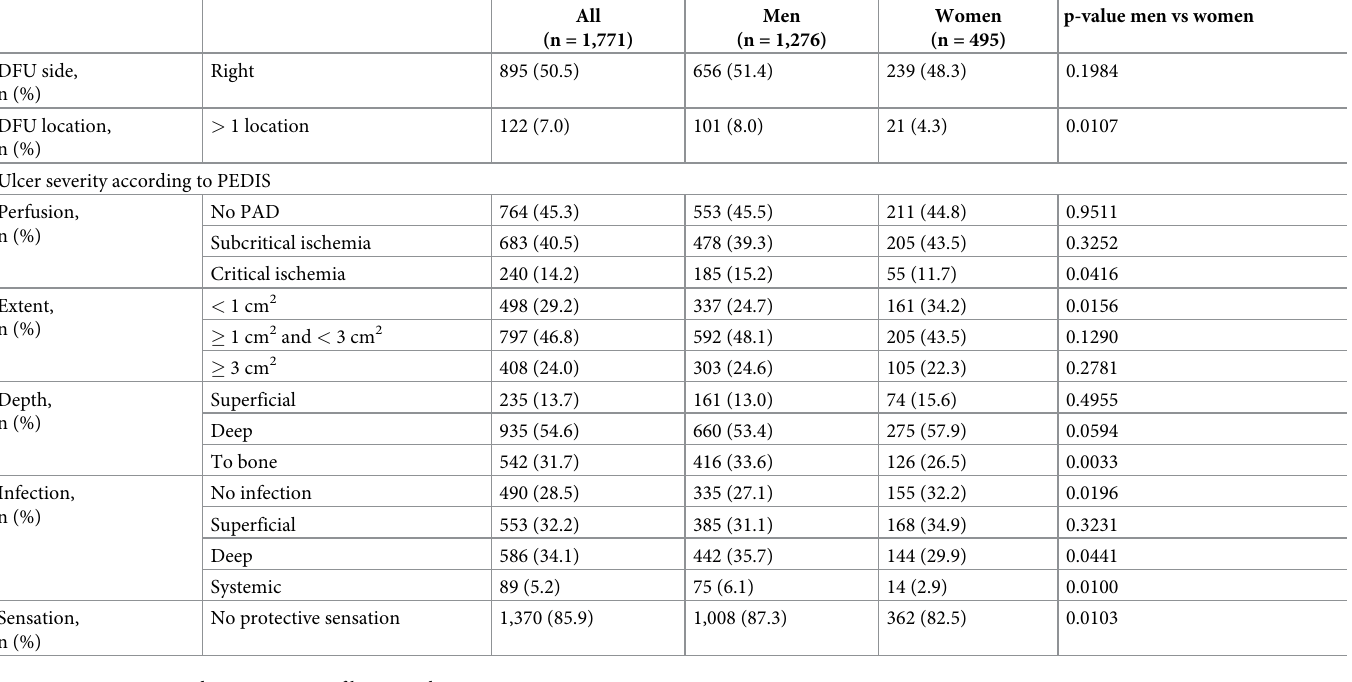
Table 2. Ulcer severity according to the PEDIS